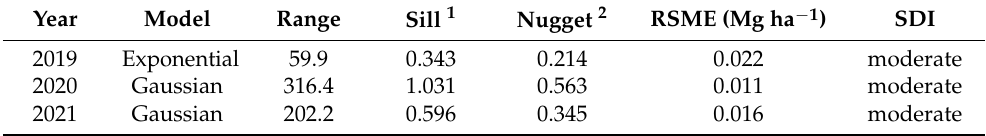
Table 3. Semivariogram model and variables used to interpolate coffee yield